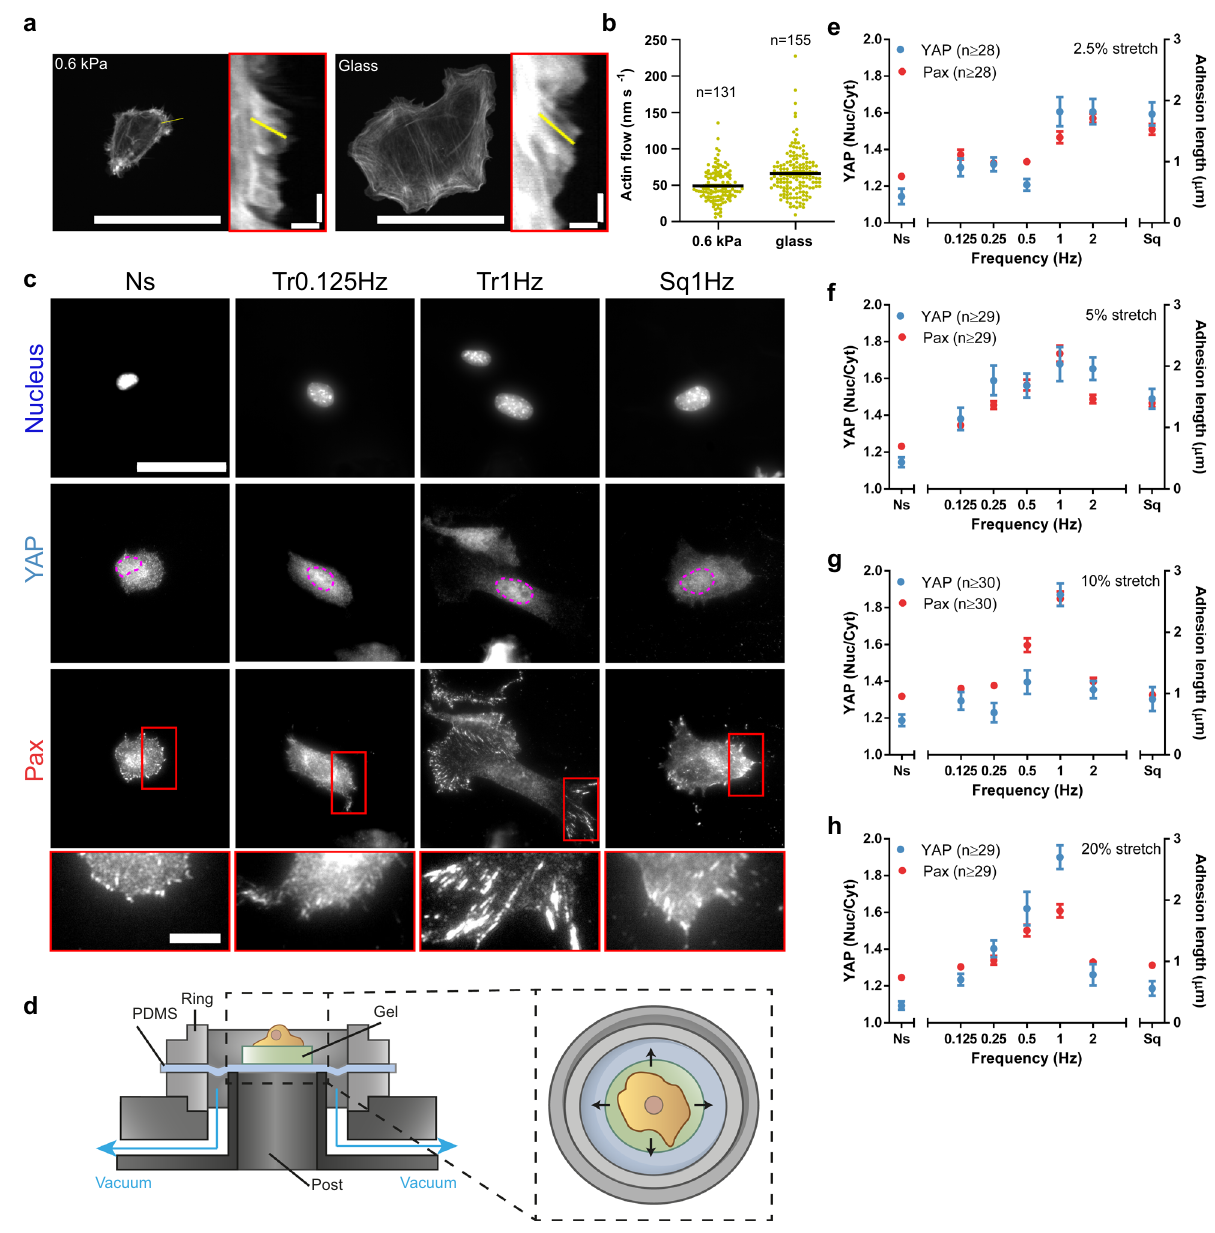
Fig. 1 The rate of cell stretch drives mechanosensing in a biphasic manner. a Cells transfected with LifeAct-GFP and plated on polyacrylamide gels of 0.6 kPa or on glass. Insets are kymographs showing the movement of actin features along the lines marked in yellow. b Actin retrograde fl ow of cells cultured on 0.6 kPa gels or glass. n numbers are traces. c Nuclear, YAP, and paxillin stainings of cells stretched by 10% using the setup using triangular (Tr) and square (Sq) signals at different frequencies. Ns non-stretched cells. In YAP images, magenta outlines indicate the nucleus. In paxillin images, areas circled in red are shown magni fi ed below. d Illustration of the stretch setup. e – h Quanti fi cations of YAP nuclear to cytoplasmic ratios and paxillin focal adhesion lengths for cells stretched at 2.5 % ( e ), 5% ( f ) 10% ( g ), and 20% ( h ). Results are shown for non-stretched cells (Ns), cells stretched with triangular signals at different frequencies, and cells stretched with a square signal at 1 Hz (Sq). The effects of frequency were signi fi cant for both YAP and paxillin in all panels ( p < 0.0001). The effect of square versus triangular 1 Hz signals was signi fi cant for paxillin at 5% stretch ( p = 0.0025) and for both YAP and paxillin for 10 and 20% stretch ( p < 0.0001). Statistical signi fi cance was assessed with Kruskal – Wallis tests. n numbers are cells. Scale bars are 50 μ m in cells, 2 μ m/40 s in kymographs ( x / y axes), and 10 µ m in magni fi cations. Data are shown as mean ±